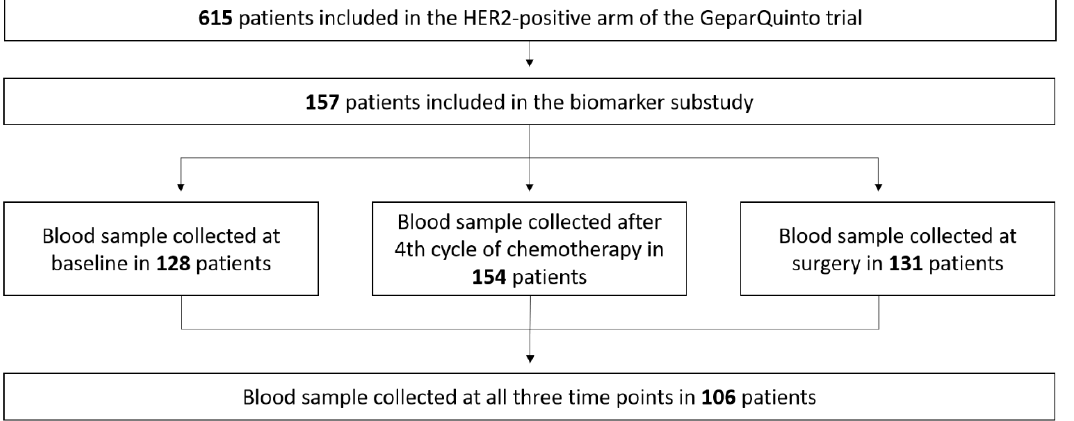
Figure 2. Flow diagram showing the number of patients with a blood sample collected at different time points.